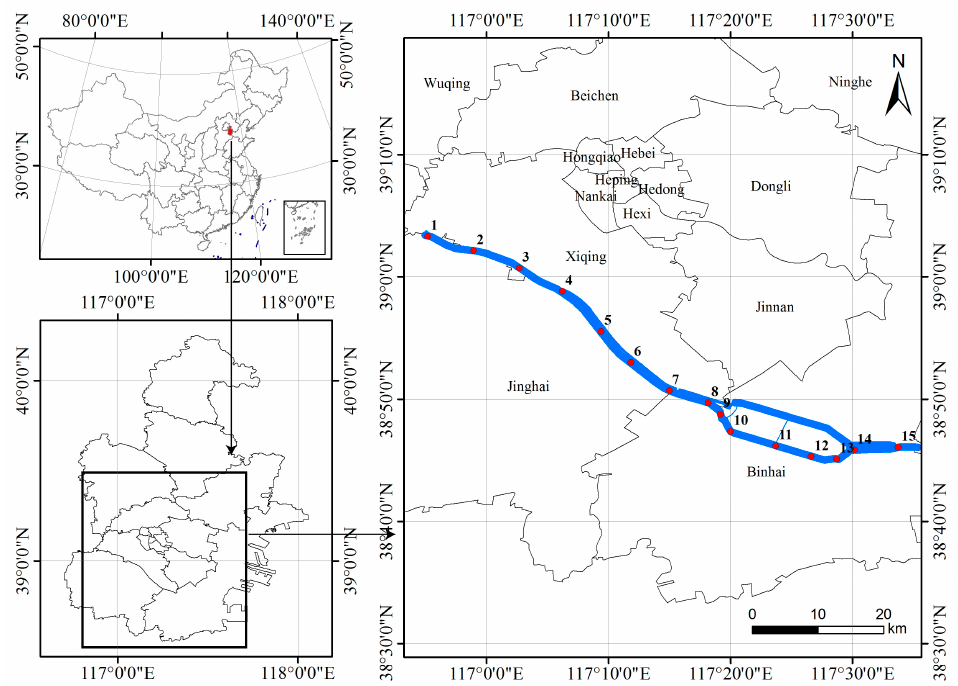
Figure 1. Location map of studied area and sampling stations. Red dots are sampling station.